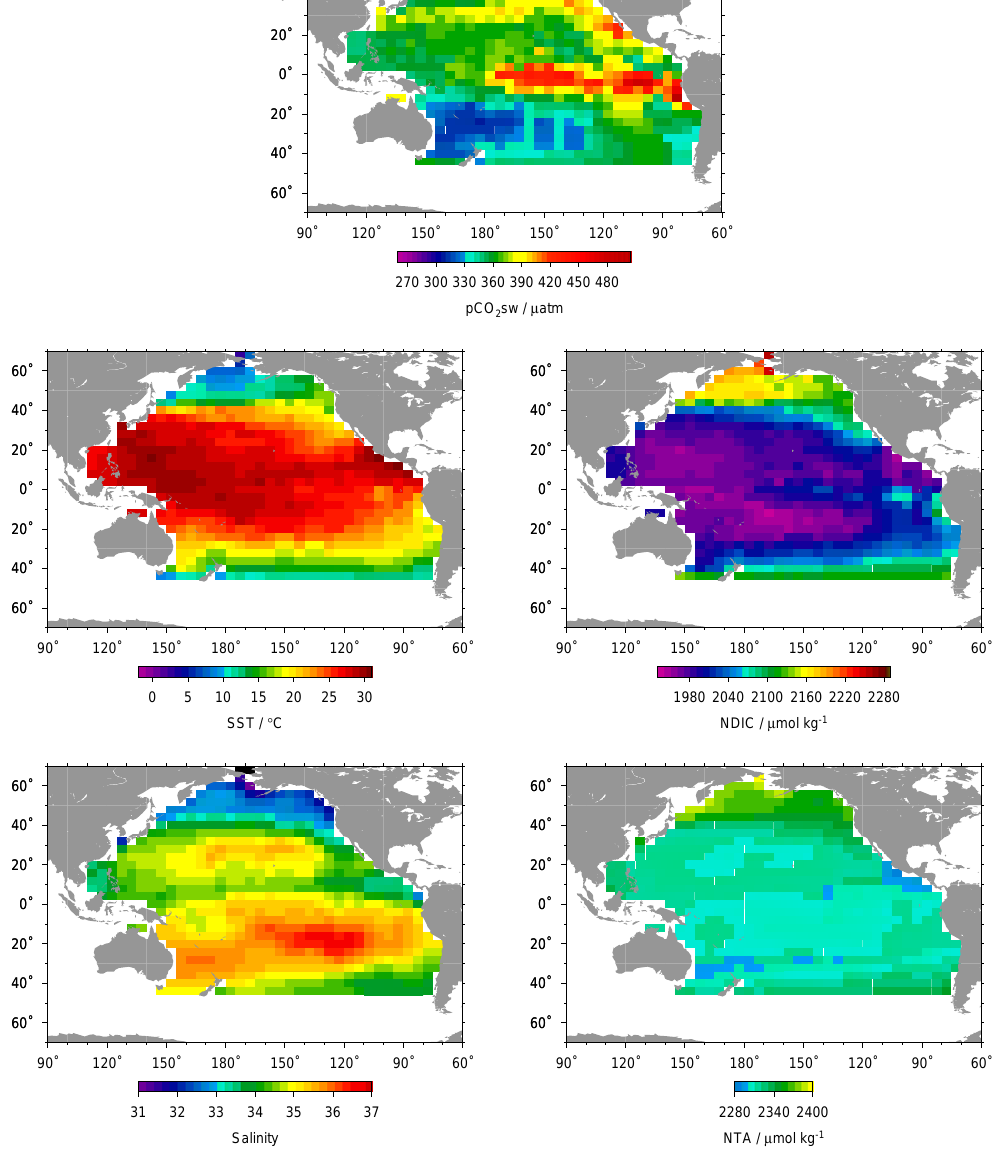
Fig. 2. Same as Fig. 1 but in August.